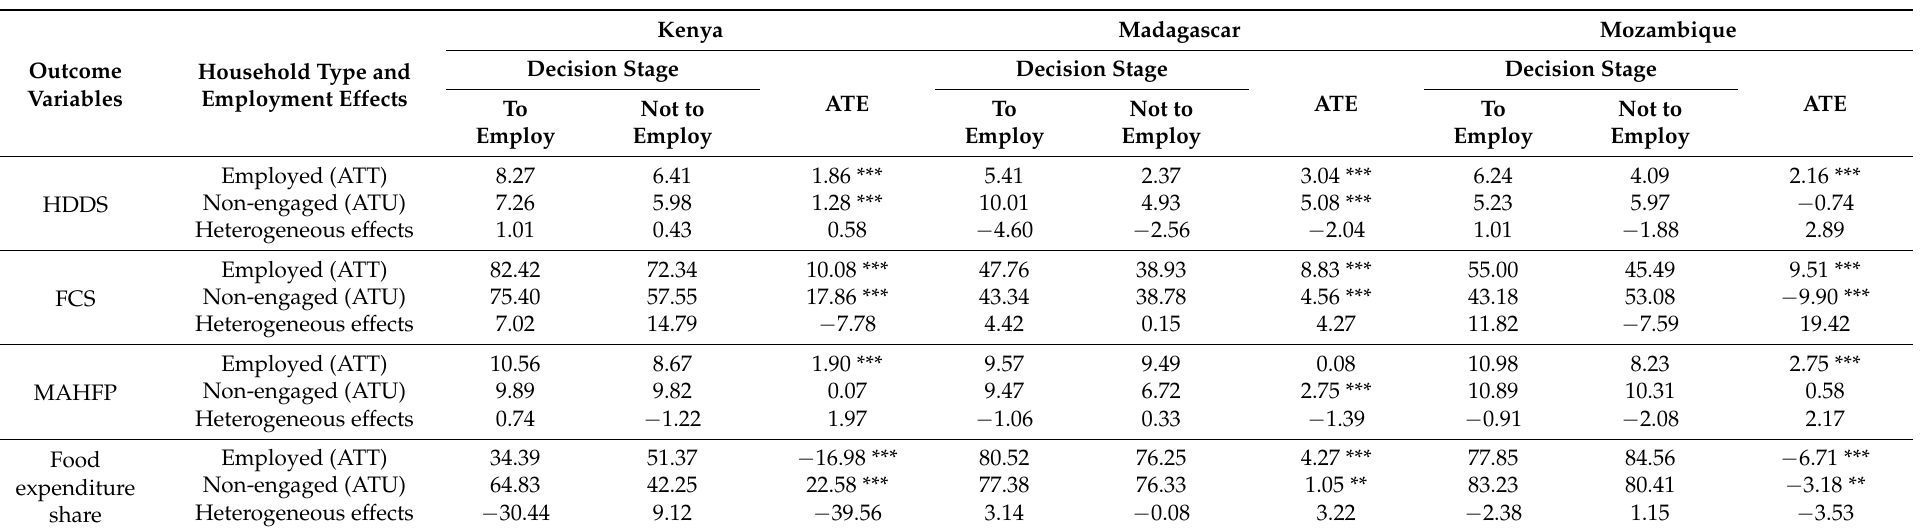
Table 8. Endogenous switching regression treatment